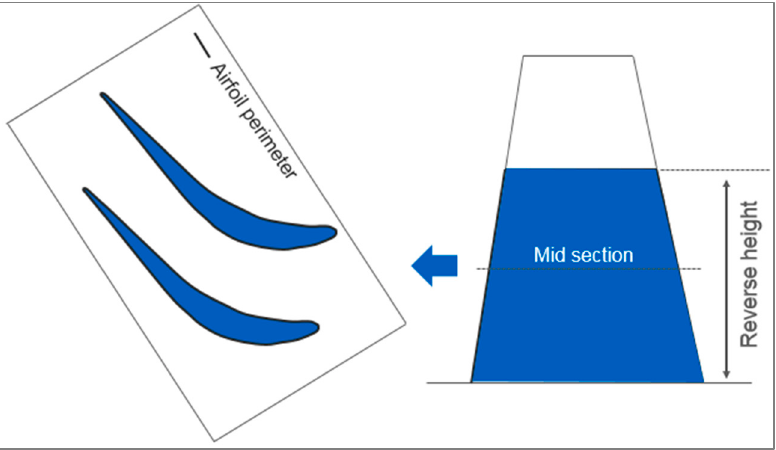
Figure 9. Schematic representation of the airfoil perimeter at the midsection and reverse-flow height. K is calculated according to Equation